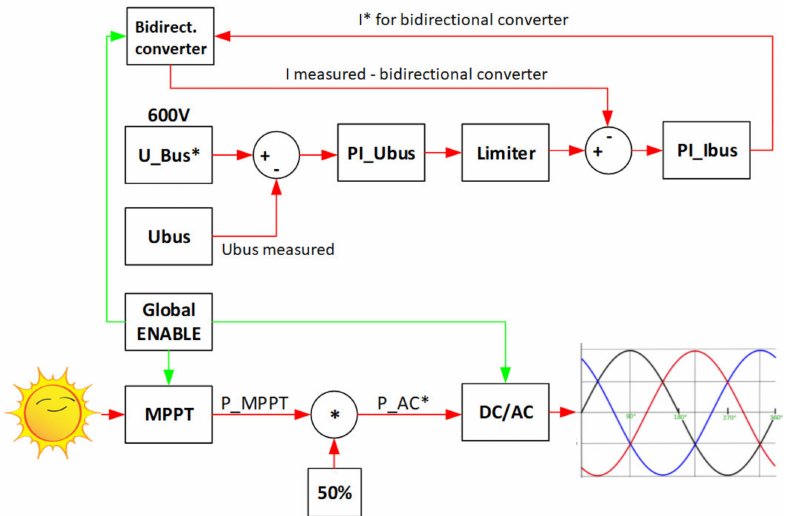
Figure 18. Block diagram of supervising control system applied during Scenario